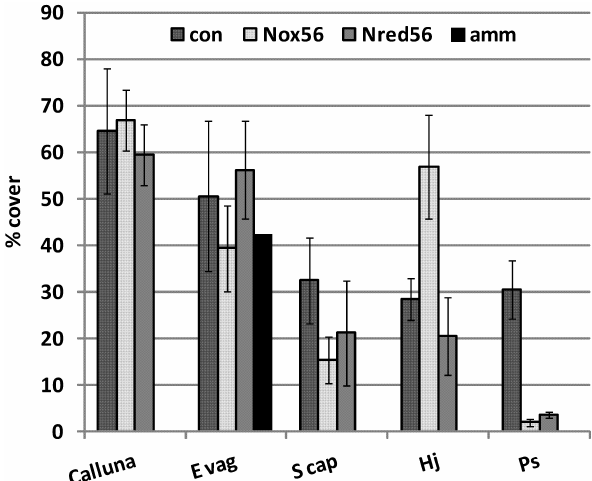
Fig. 1. Percentage cover of the main species Calluna , Eriopho- rum vaginatum (Evag), Sphagnum capillifolium (S cap), Hypnum jutlandicum (Hj) and Pleurozium schreberi (Ps) ( + / − sterr) grow- ing in the 12.8m 2 plots on the control (no added N) and N treated (oxidised (Nox), reduced (Nred) and ammonia (amm))plots ( ∼ 56kgNha − 1 yr − 1 ) at Whim bog in 2009. Note that the mosses and Calluna have gone from the NH 3 plots.